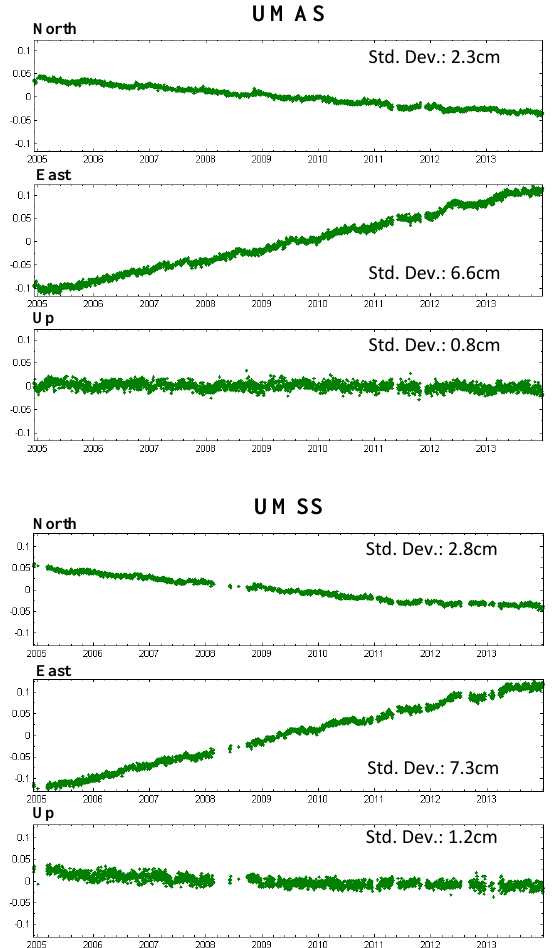
Figure 5. The time series of MyRTKnet daily solutions from December 2004 to 2013 for the four selected stations and their standard